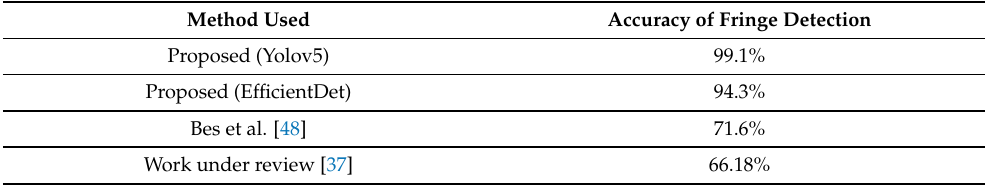
Table 5. Comparison of testing results when using various experimental speckle affected SMI signals having variable optical feedback